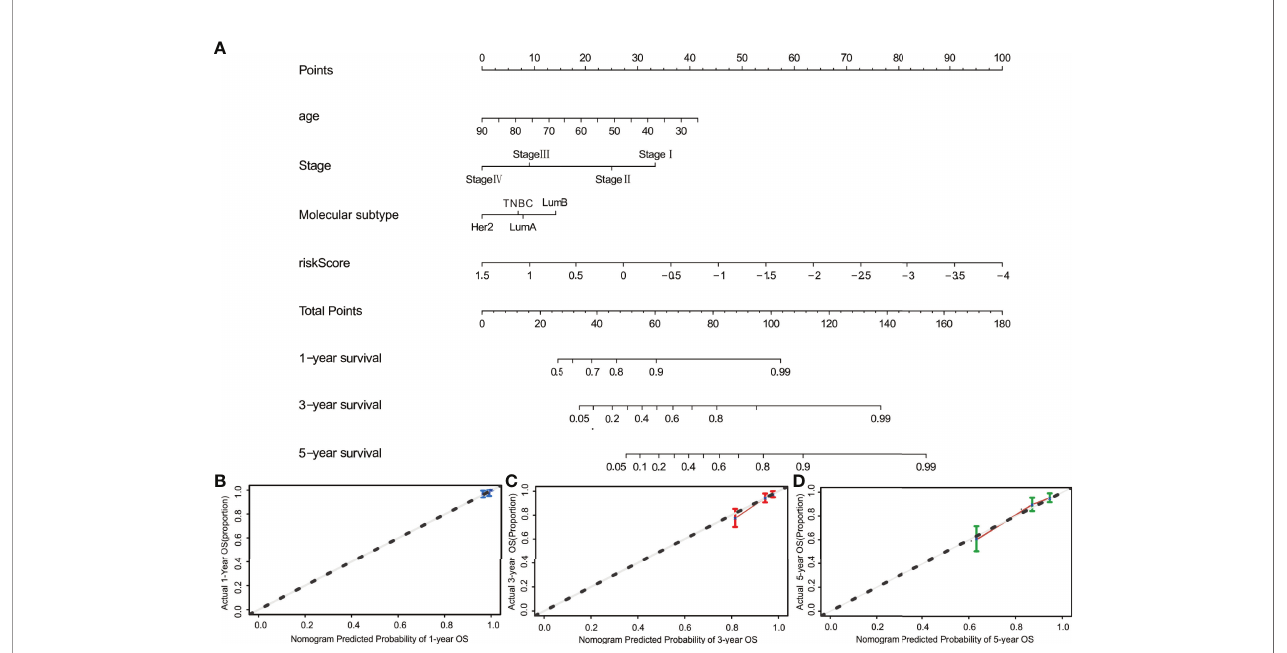
FIGURE 7 | Construction of the nomogram. (A) The nomogram for predicting 1-, 3-, and 5-year OS was constructed by combining risk score, age, stage, and molecular subtype. (B – D) The calibration curves of nomograms between predicted and observed 1-, 3- and 5-year OS. The dashed line of 45° indicates the perfect